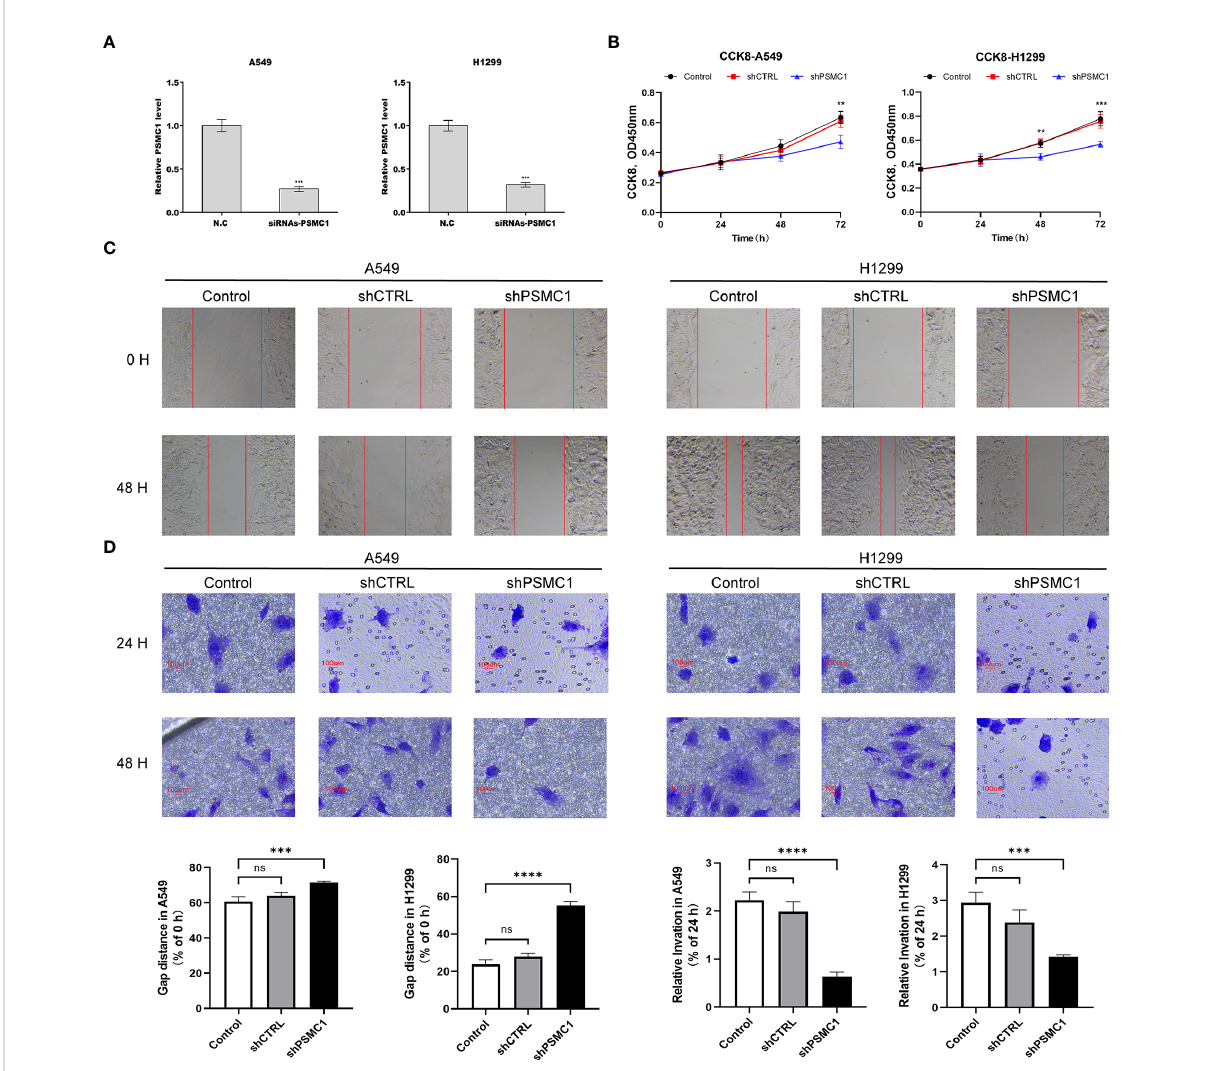
FIGURE 12 Downregulation of PSMC1 inhibits the proliferation and migration of LUAD cells. (A) The quantitative real-time PCR was performed to validate the transfected ef fi ciency. (B) CCK-8 assay was used to determine the proliferation ability of A549 and H1299. (C) The cell migration ability was analyzed using the wound-healing assay. (D) The cell migration ability was detected by the Transwell migration assay. Data represent mean ± SD from three replicates of each sample. ns, no signi fi cance; ** p < 0.01; *** p < 0.001; **** p <